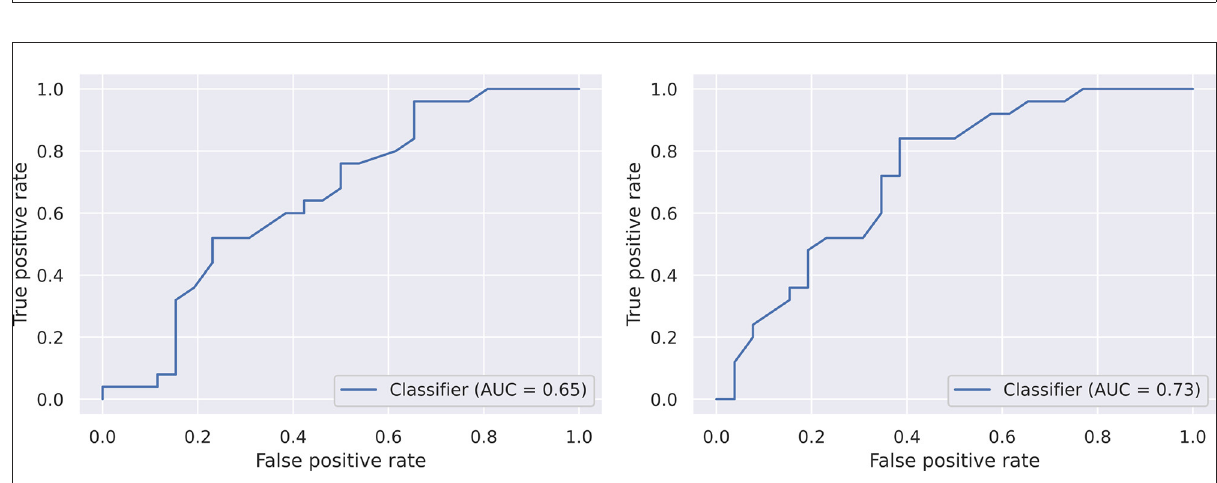
FIGURE5 Receiver operating characteristics of the two models on the dataset generated by TLPO-CV. Left , logistic regression. Right , random forest.